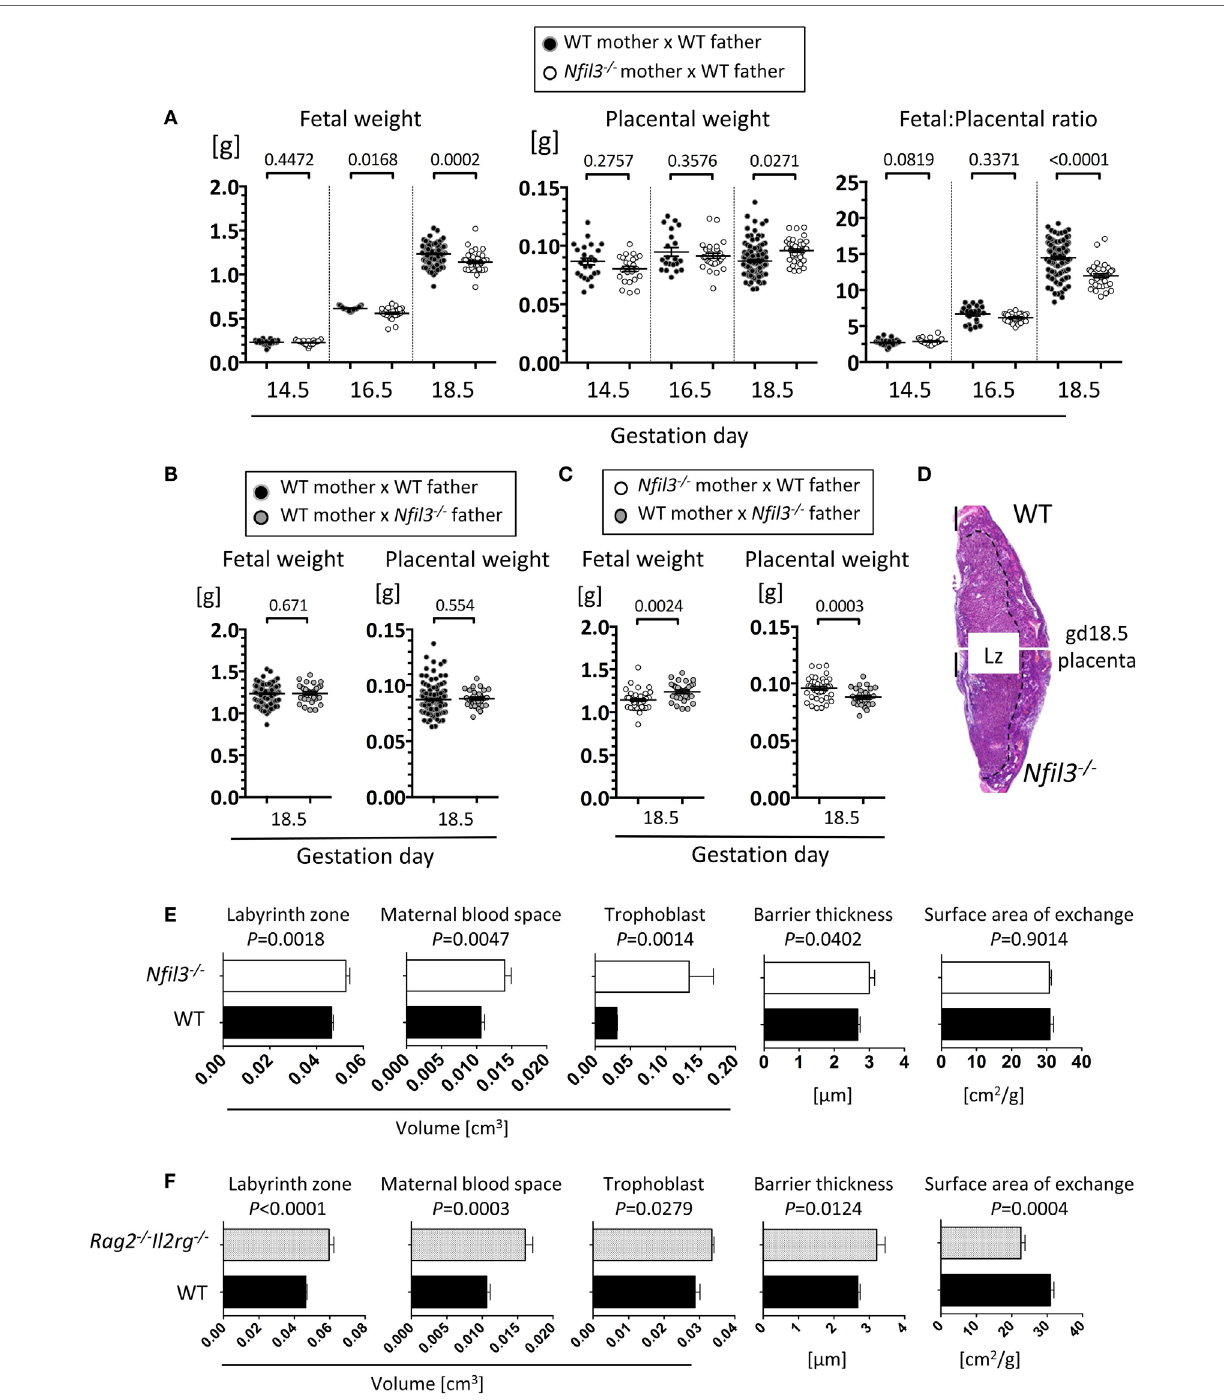
FigUre 4 | Fetal and placental abnormalities in Nfil3 − / − dams . (a) Fetal weight, placental weight, and ratio of fetal/placental weight of conceptuses from either WT or Nfil3 − / − females mated with WT males. Means ± SEM of data representative of 3–18 litters per maternal genotype per gestational age. (B) Fetal and placental weights of conceptuses from WT females mated either with WT or Nfil3 − / − males. Means ± SEM of data representative of 4–5 litters per maternal genotype. (c) Fetal and placental weight of heterozygous offspring from either Nfil3 − / − dams (a) or Nfil3 − / − fathers (B) . Means ± SEM of data representative of 4–5 litters per cross. (a–c) Statistical differences were calculated using mixed effect modeling taking into account the clustering of pups from the same litter. (D) Representative H&E staining of gd18.5 placenta from WT and Nfil3 − / − dams. The discontinuous line demarcates the labyrinth zone (Lz). (e,F) Stereological evaluation of the volume of labyrinth zone, maternal blood space, trophoblast, barrier thickness, and surface area of exchange in placentas from Nfil3 − / − dams (e) and in placentas from lymphocyte deficient Rag2 − / − Il2rg − / − dams (F) , both compared to those from WT dams. Data representative of 5–11 placentas per genotype for Lz volume and 4–9 placentas for Lz structure (MBS, trophoblast, BT, and SA). Statistical differences were calculated with an unpaired Student’s t